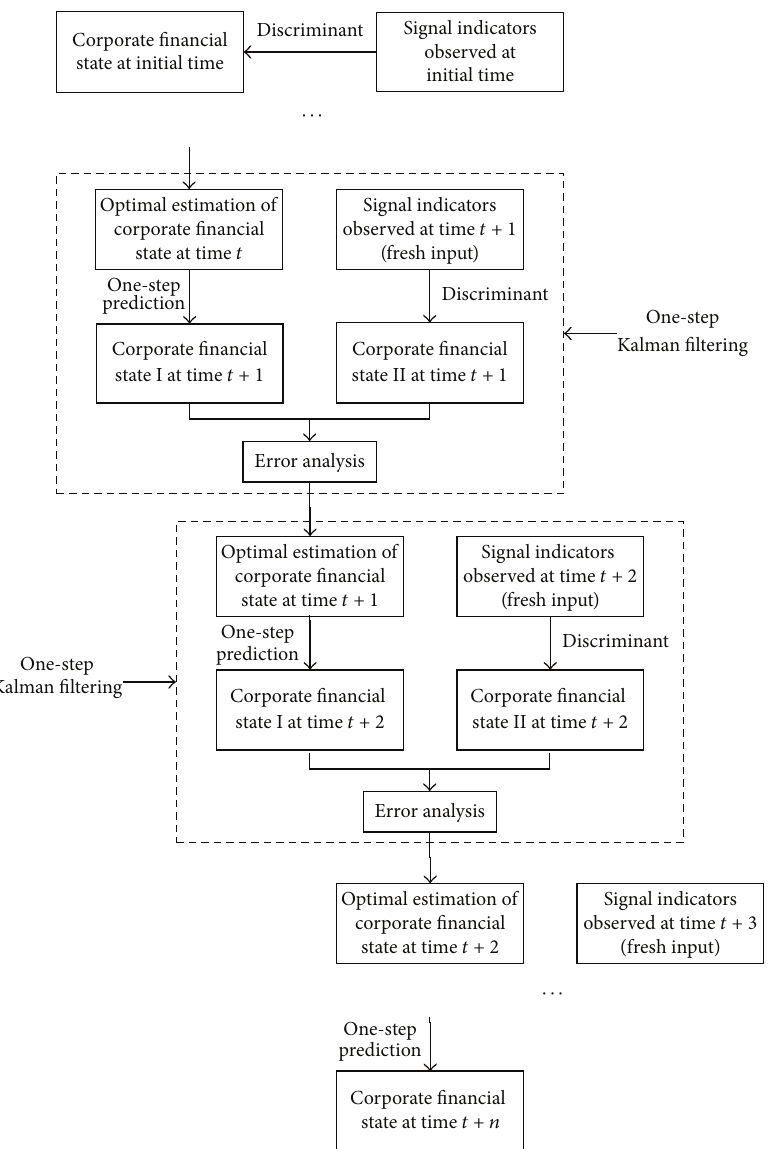
Figure 2: A whole process of dynamic prediction for corporate financial